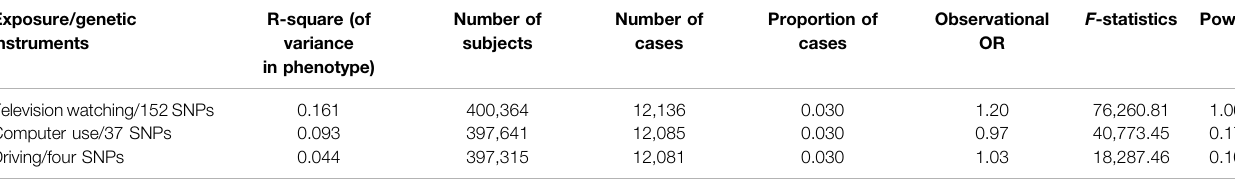
TABLE 3 | Power calculation for Mendelian randomization analysis. Exposure/genetic